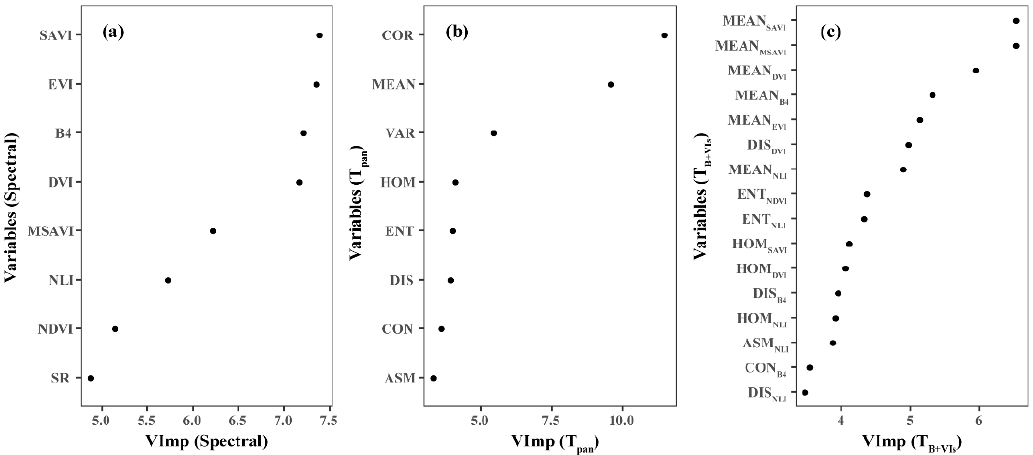
Figure 3. Number of explanatory variables selected by the Boruta algorithm and their importance values: ( a ) spectral variables; ( b ) T pan ; ( c ) T B+VIs . (VImp represent the variable’s importance values).